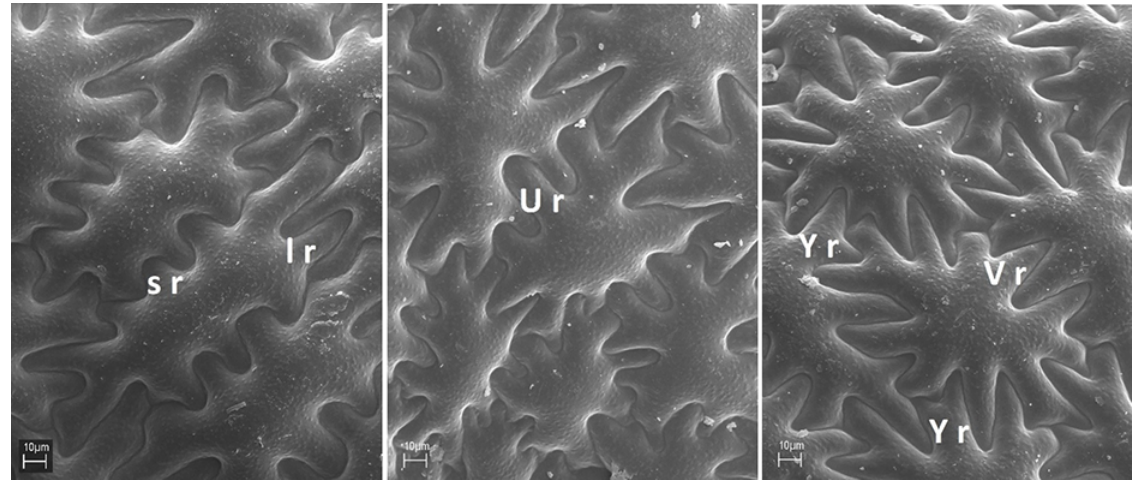
Figure 1 Morphological features of testa epidermal cells. Abbreviations: sr – short rays; lr – long rays, Ur – U-rays, Vr – V-rays, Yr – bifurcated rays.